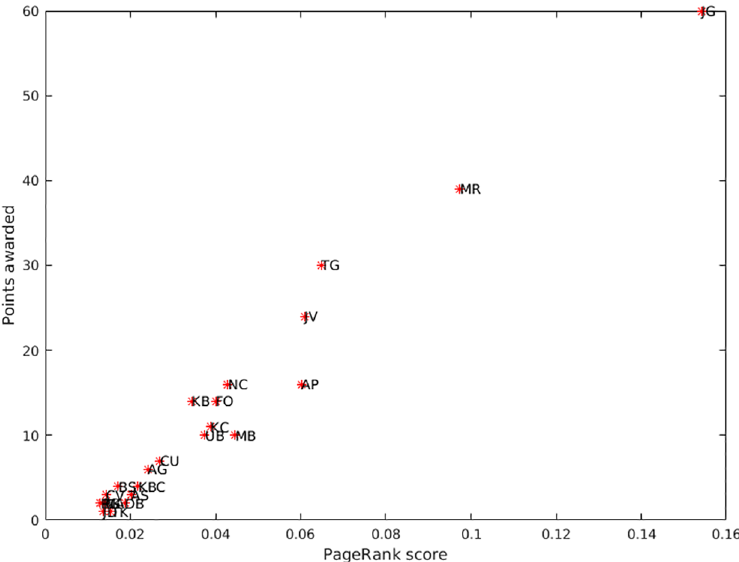
Fig 4. Scatter plot of the paired PageRank scores and points (calculated using the 2016 points system)awarded to the top 23 athletes.